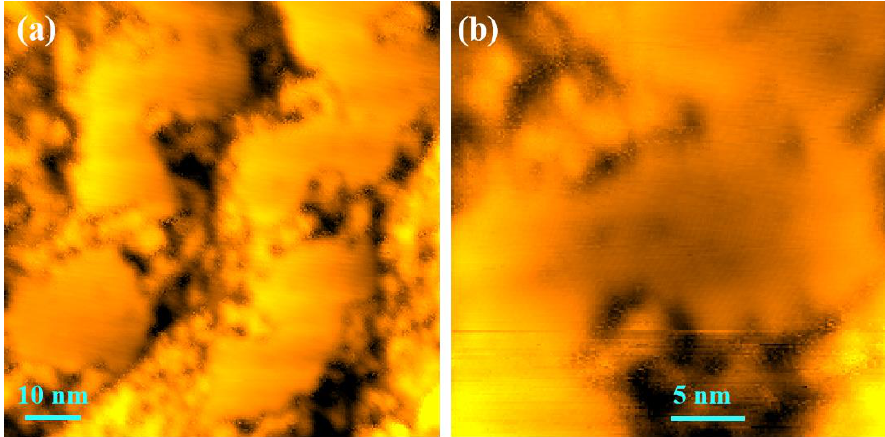
Figure A1. ( a , b ) High-resolution STM images from Process Ⅰ indicating disordered surface structures at this stage. Here, the scanning bias voltage and current are equal to 1 V and 0.1 nm, respectively.